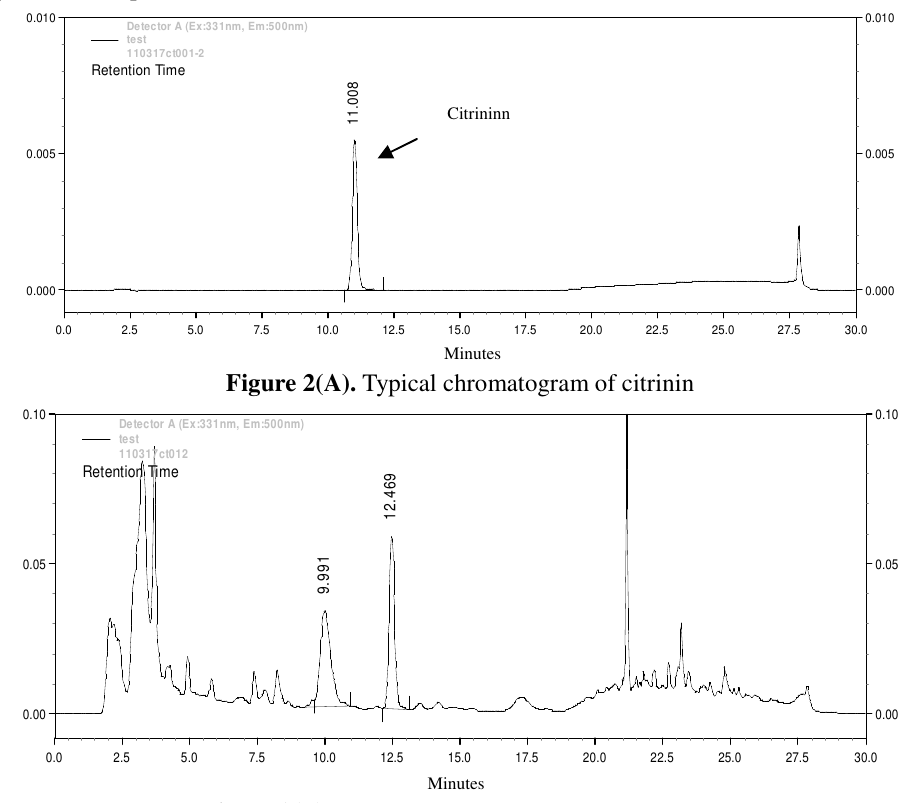
Figure 2(A). Typical chromatogram of citrinin